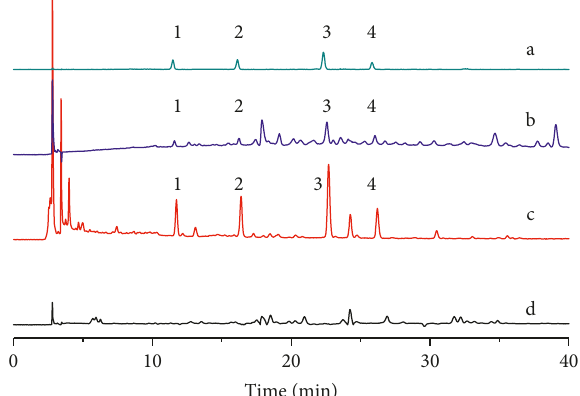
Figure 2: HPLC-UV chromatogram of (a) four phenylethanoid glycosides mixed standards, (b) LDC solution A, (c) herbal Radix Rehmanniae test solution, and (d) negative sample solution A with gradient program A (1) purpureaside C, (2) jionoside A1, (3) acteoside, and (4)